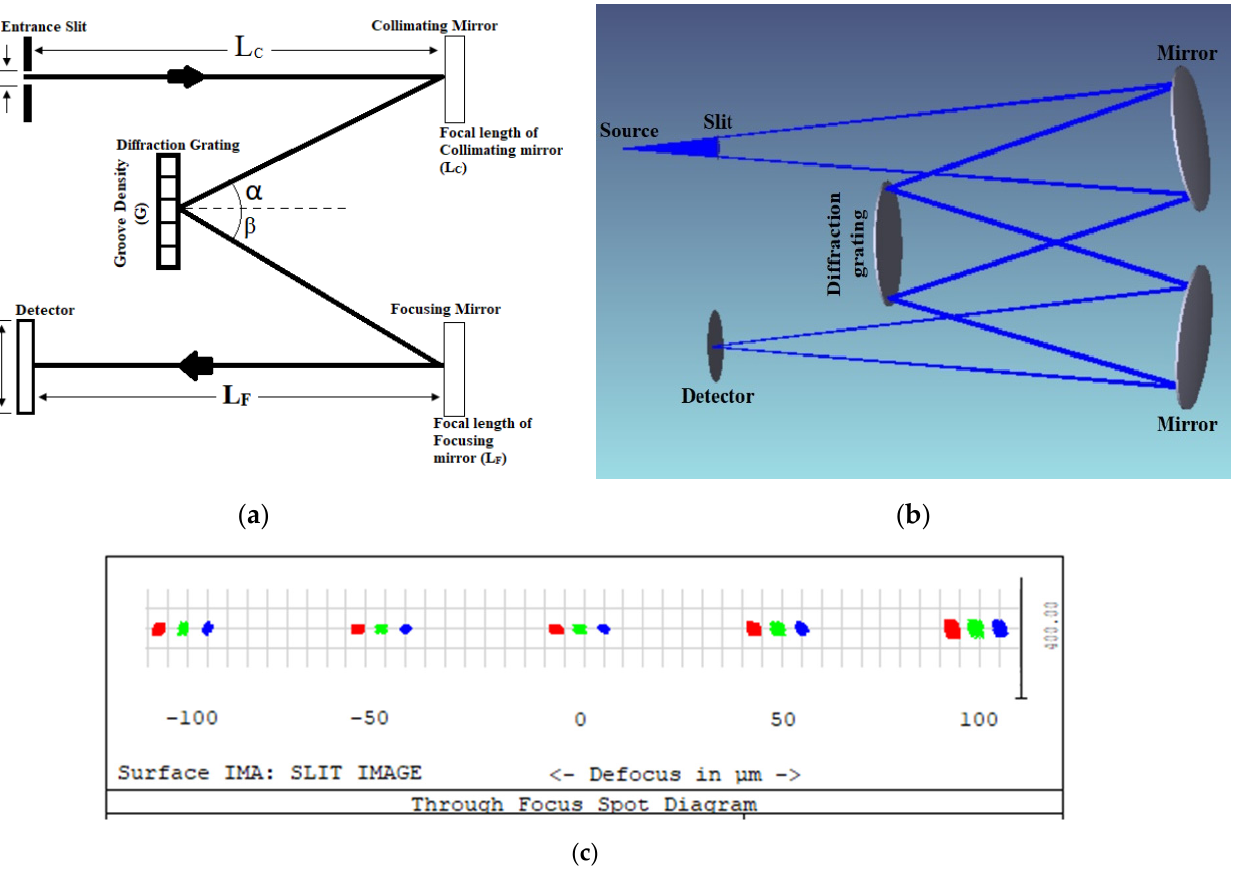
Figure 1. ( a ) Schematic representation of Czerny–Turner configuration-based spectrometer; ( b ) schematic of the simulated design of the spectrometer in OpticStudio. ( c ) Variation in spot diagram relative to the distance of the detector from the focal point of focusing mirror.